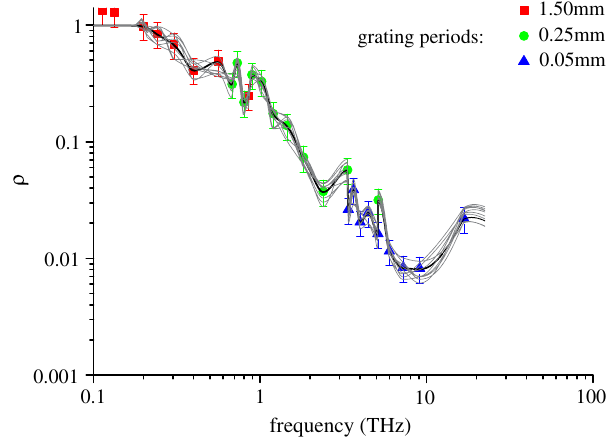
FIG. 7. The magnitude ( ρ ) of the FT of the time profile of the bunch for a “ high compression ” run on the April 9, 2013.